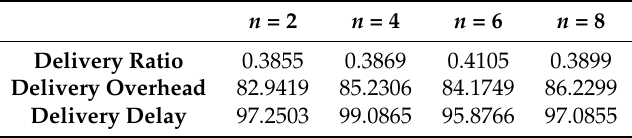
Table 4. Delivery ratio with different